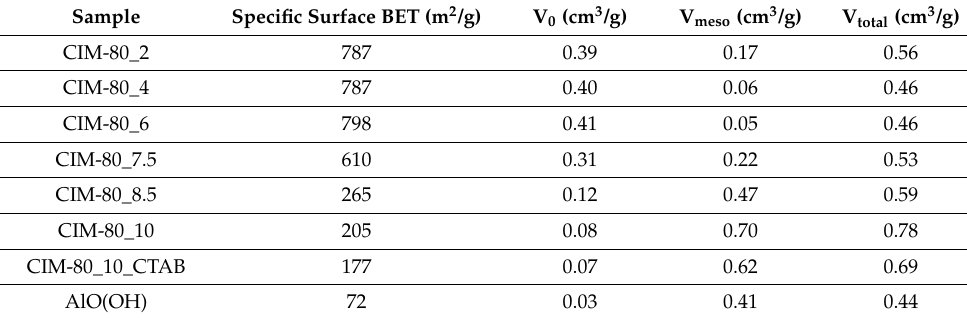
Table 2. Textural properties obtained by the N 2 isotherms.